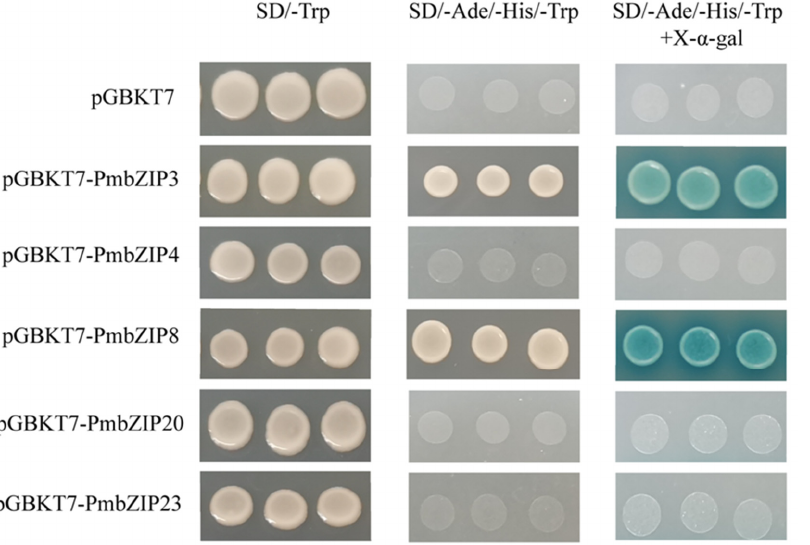
Figure 8. Transcriptional activity analysis of PmbZIP proteins. The growth state of the pGBKT7 (control), pGBKT7-PmbZIP3, pGBKT7-PmbZIP4, pGBKT7-PmbZIP8, pGBKT7-PmbZIP20 and pGBKT7-PmbZIP23 on SD/-Trp, SD/-Ade/-His/-Trp and SD/-Ade/-His/-Trp + X- α -gal medium.